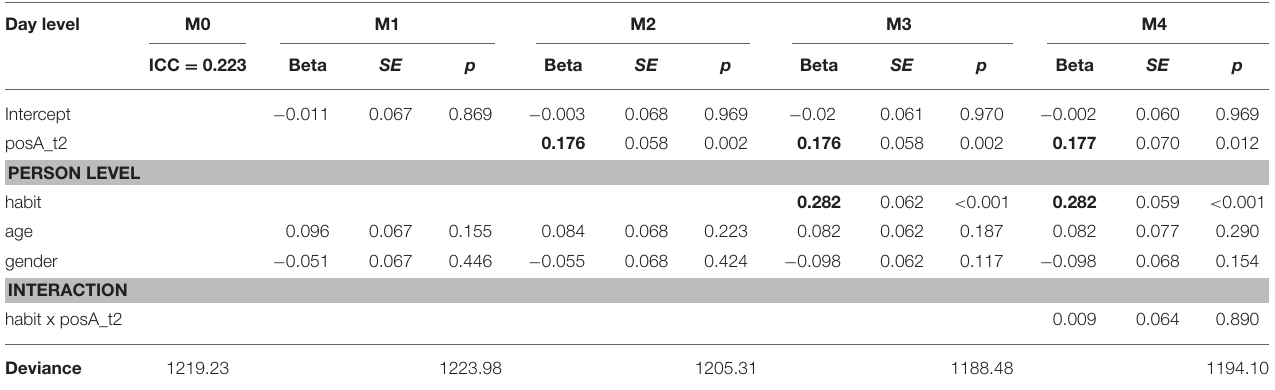
TABLE 3 | Model 2.1: Prediction of self-reported after work MVPA by positive affect and habit strength. Day level